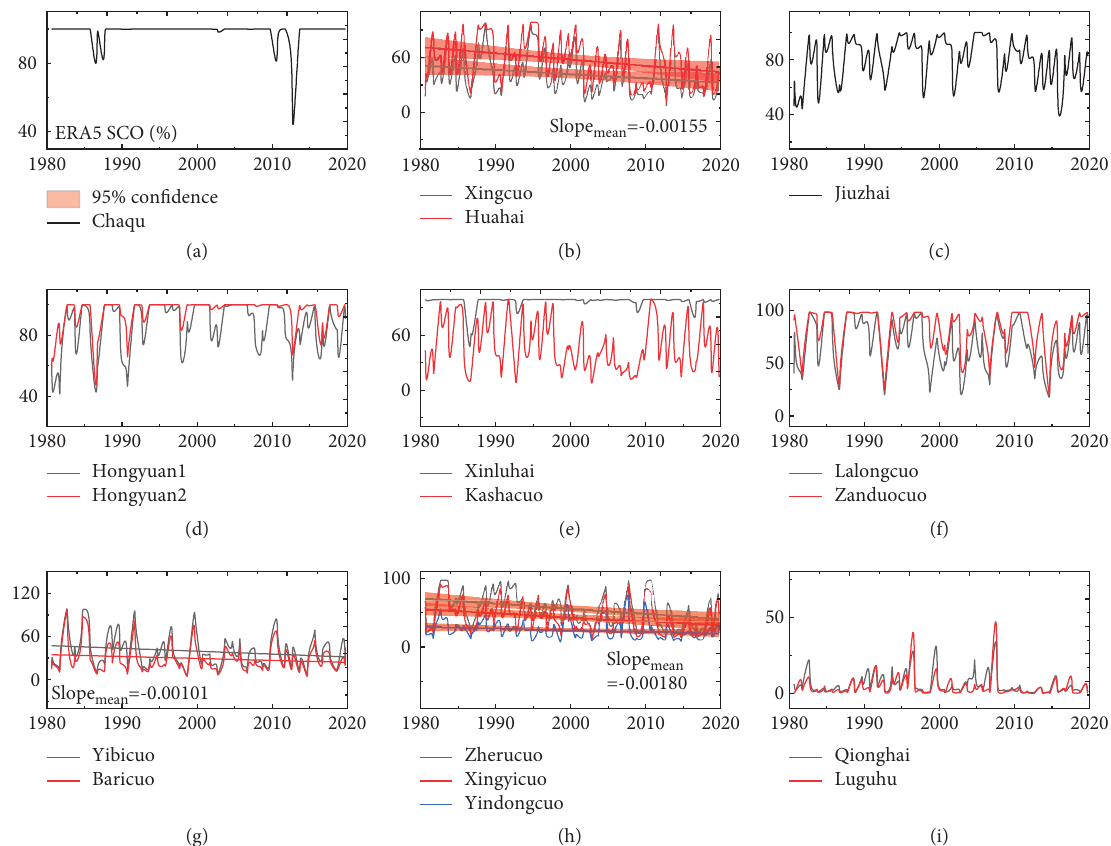
Figure 13: SCO change trend of the lake wetland on a site scale (2000–2020). Latitude of the lake site gradually decreased from subfigure (a) to (i). Elevation of sites (a), (d), (g), (f), and (h) are above 4500m, elevation of sites (b), (c), and (e) are about 3000–3900m, and elevation of site (i) is less than